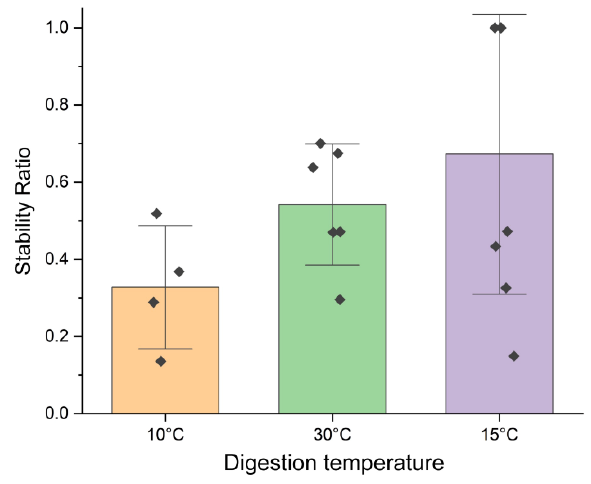
Figure 3. Stability ratios calculated for nuclease protection assays using the ABzIM-ITO probe and the 15-mer RNA standard containing an internal GGACU motif using different digestion temperatures. Individual data points are represented by black diamonds. Error bars represent ±1 SD.